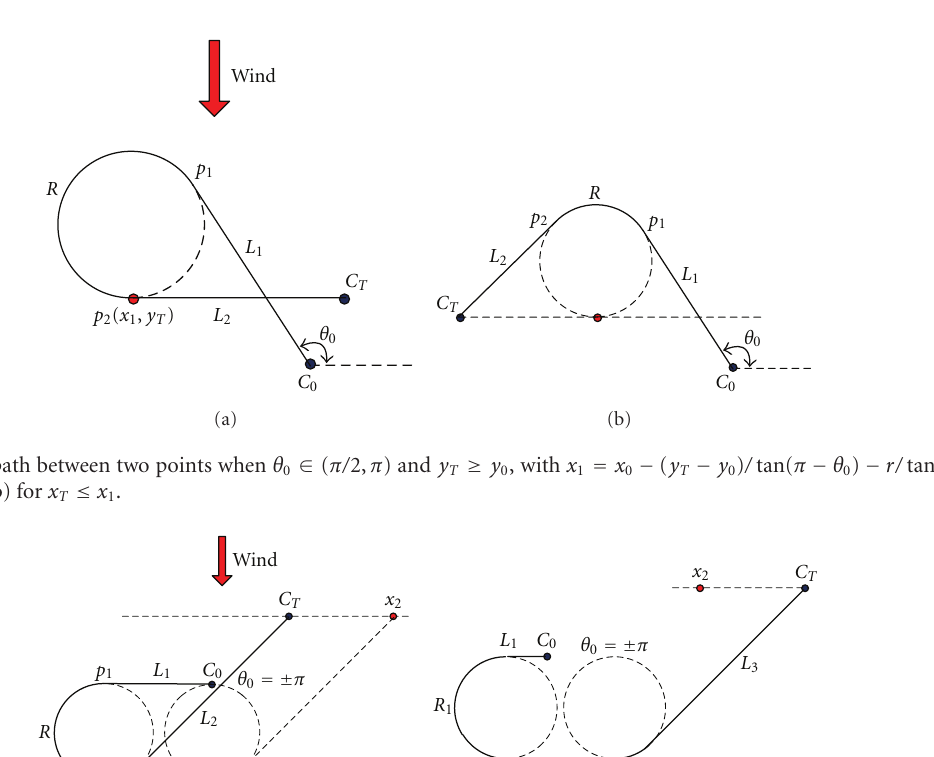
Figure 11: Wearing path between two points when θ 0 = 0 and y T ≥ y 0 . (a) For x T > x 2 and (b) for x T ≤ x 2 .